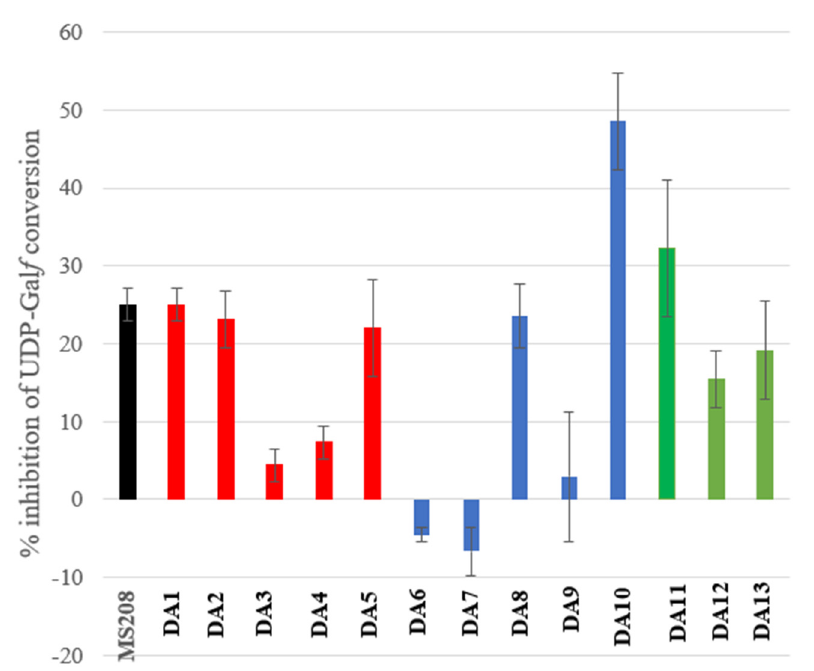
Figure 3. % Inhibition of Mtb UGM at 15 µM of UDP-Gal f using 60 µM of the test compounds. % Inhibition bar of MS208 in black, C -acyl pyrazole derivatives ( DA1 – DA5 ) in red, O -acyl pyrazole derivatives ( DA6 – DA10 ) in blue and triazolo derivatives ( DA11 – DA13 ) in green.